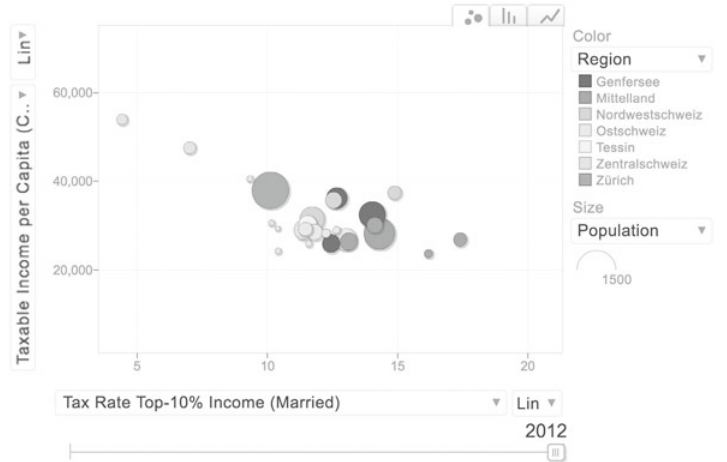
Figure 9: Taxable income per inhabitant (vertical axis) and Consolidated cantonal (cid:2) municipal effective average tax rate for a married couple without children and top-10% income (horizontal axis) across Swiss cantons in 2012. Average across municipalities weighted by the number of